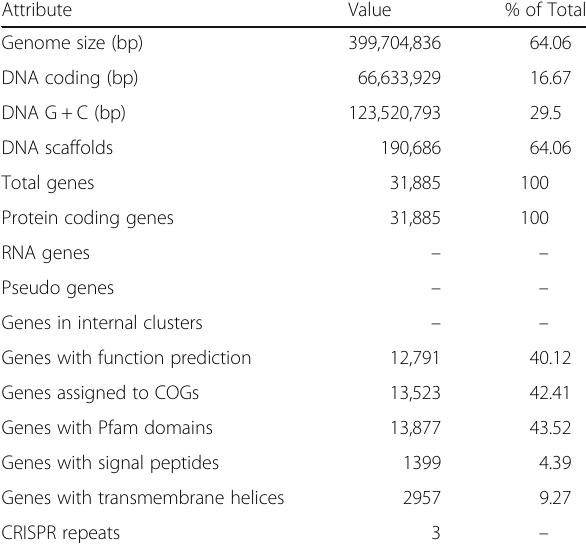
Table 3 Genome statistics